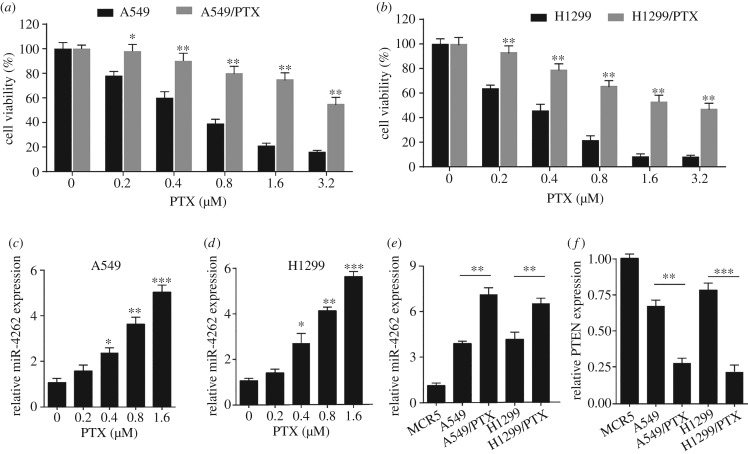
The expression patterns of miR-4262 and PTEN in PTX-sensitive or PTX-resistant NSCLC cells. (a,b) The PTX-resistant cell lines A549/PTX and H1299/PTX and A549 and H1299 cells were treated with different concentrations of PTX, and a CCK-8 assay was employed to analyse cell viability. *p < 0.05 and **p < 0.01 versus the A549 or H1299 group. (c,d) miR-4262 expression in A549 and H1299 cells treated with different doses of PTX. *p < 0.05, **p < 0.01 and ***p < 0.001 compared with the 0 µM group. (e) The expression of miR-4262 was evaluated by qRT-PCR assays in A549, A549/PTX, H1299 and H1299/PTX cells. **p < 0.01. (f) The mRNA expression level of PTEN in in A549, A549/PTX, H1299 and H1299/PTX cells were determined by qRT-PCR. **p < 0.01 and ***p < 0.001.